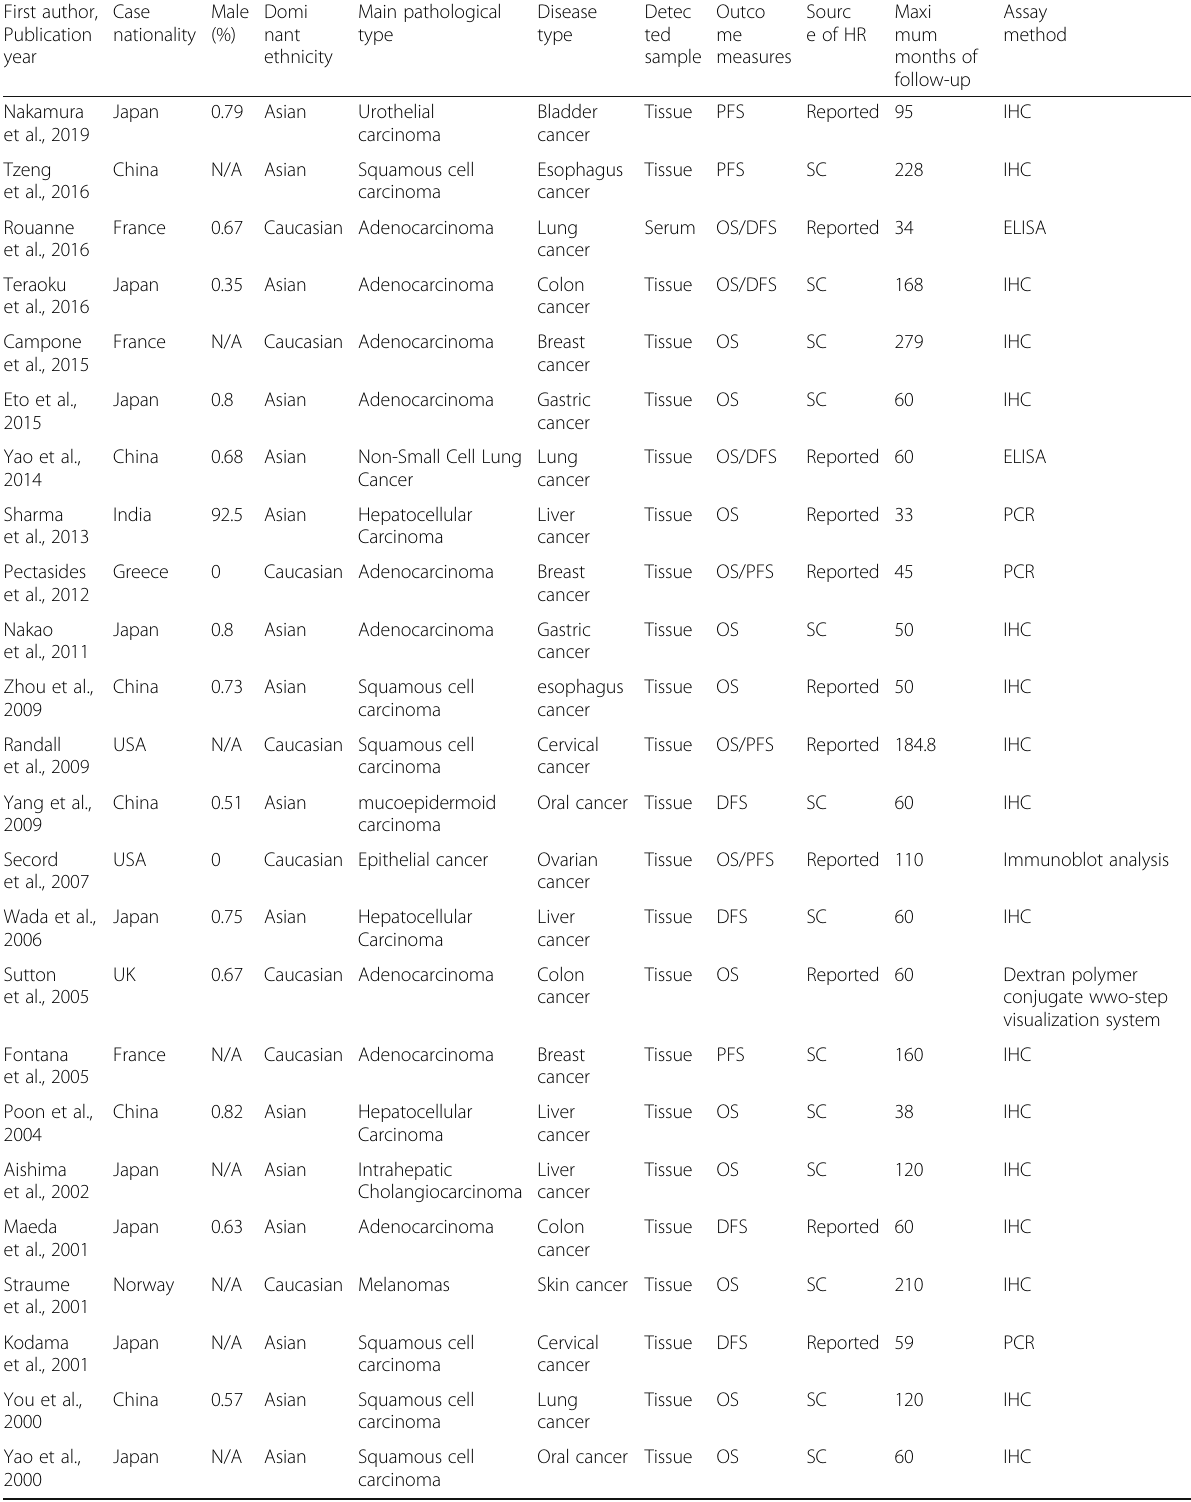
Table. 1 Main characteristics of studies included in the